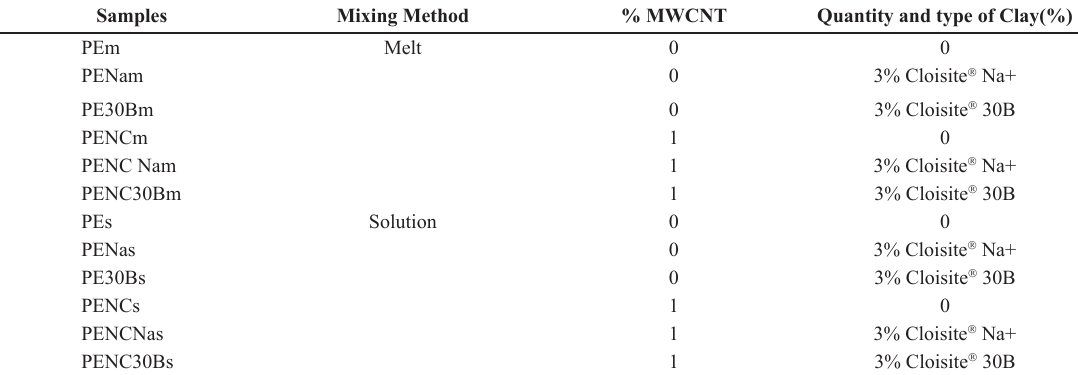
Table 1. Nomenclature and composition of the